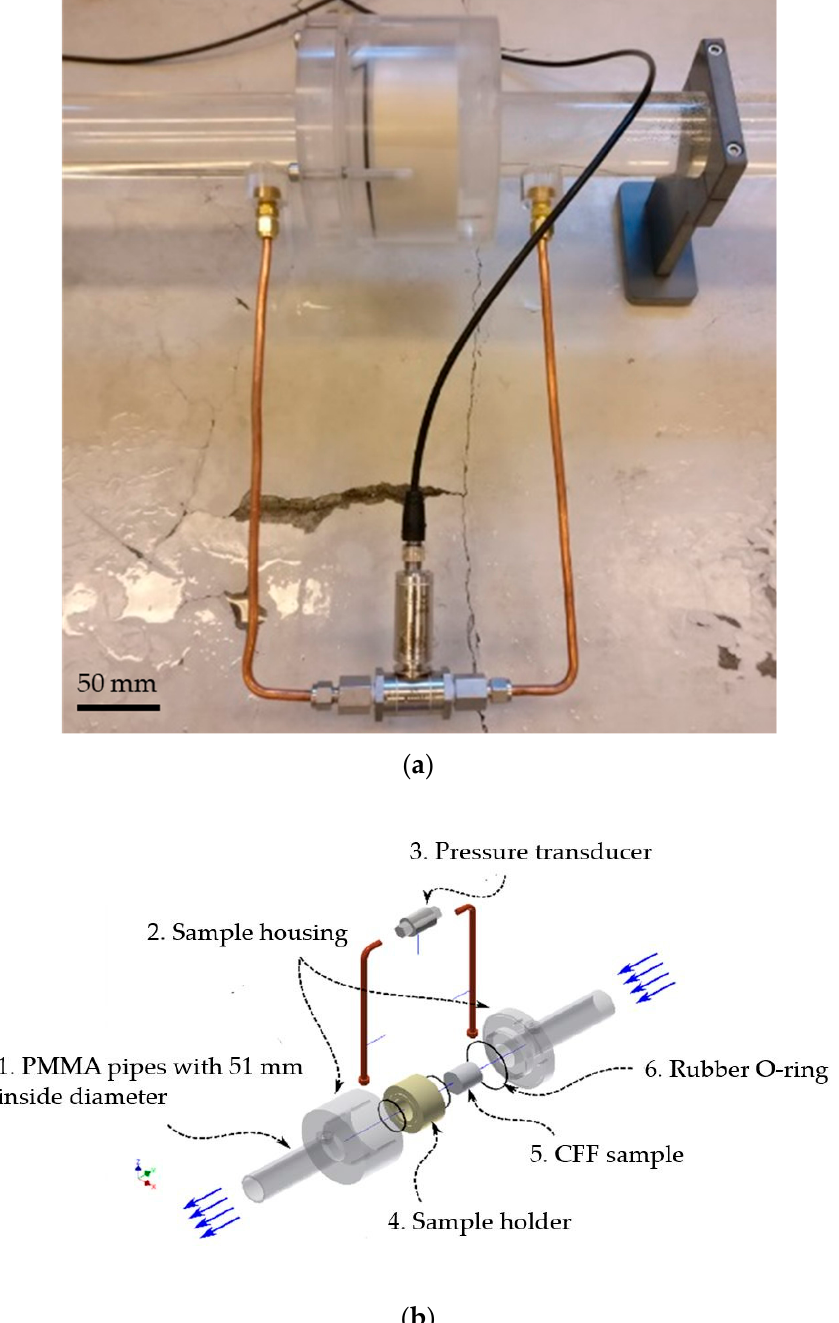
Figure 6. The sample housing in more detail. ( a ) setup for holding the CFF sample and measuring the pressure drop using a transducer. ( b ) The exploded 3D CAD drawing of the sample housing: (1) PMMA (Poly Methyl Methacrylate) pipes to transport the water in the system, (2) Plexiglas housing to hold the CFF sample holder in place throughout the experiment, (3) Pressure transducer, (4) sample holder encompassing the sample to make a straight-through filter design, (5) CFF sample, and (6) Rubber O-rings used to prevent water bypass between the sample holder and the housing.